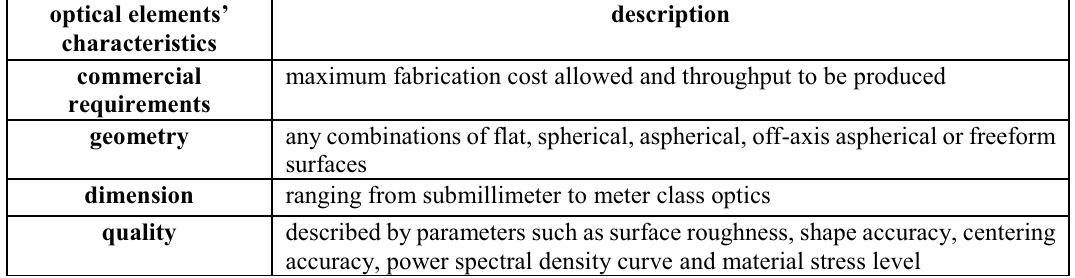
Table2. Classification of optical elements